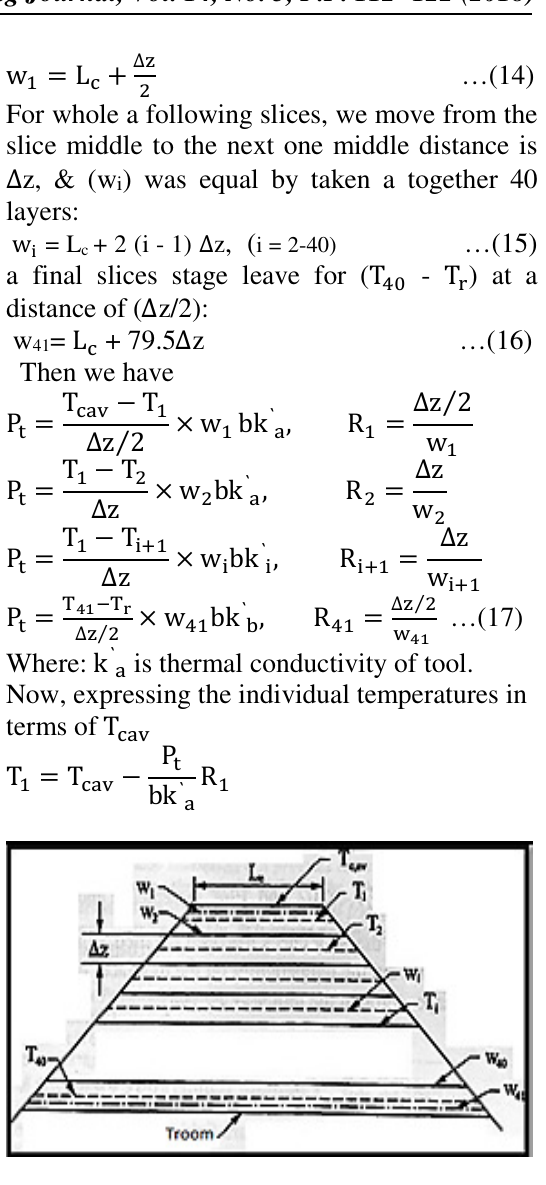
Fig. 5. Specification of die thermal field in the tool as steady-state single-dimensional